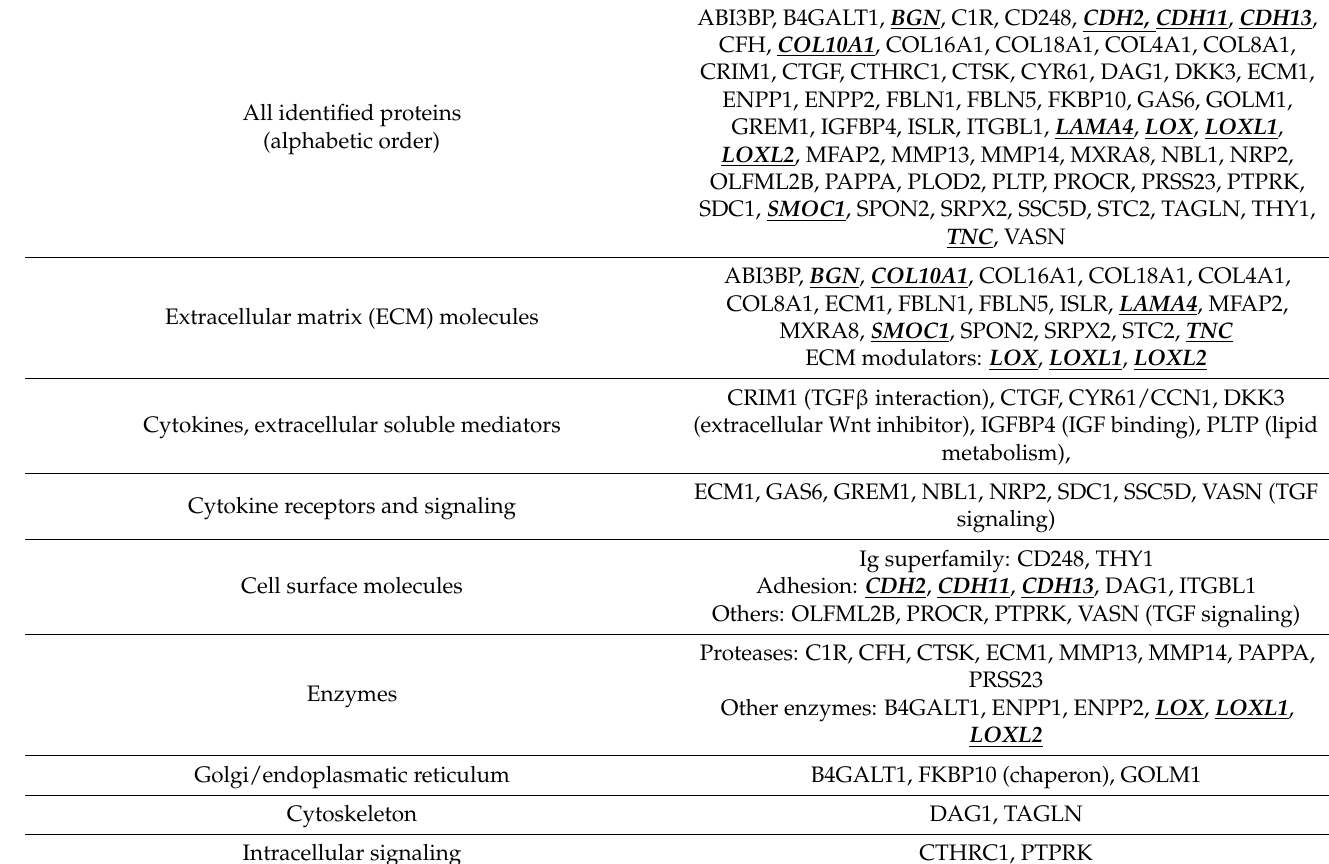
Table 4. An overview of 60 individual proteins that showed detectable constitutive release by the AML cells for 10 or fewer of the 40 patients (i.e., detected in AML-CM), but showed detectable supernatant levels for at least 30 patients when MSCs were cultured with AML-CM (i.e., MSC/AML-CM). All proteins were quantified in at least five of the seven culture replicates of MSCs alone. The classification is based on information in the Gene database. Proteins that are important for the support of normal hematopoietic stem cells are marked in the table